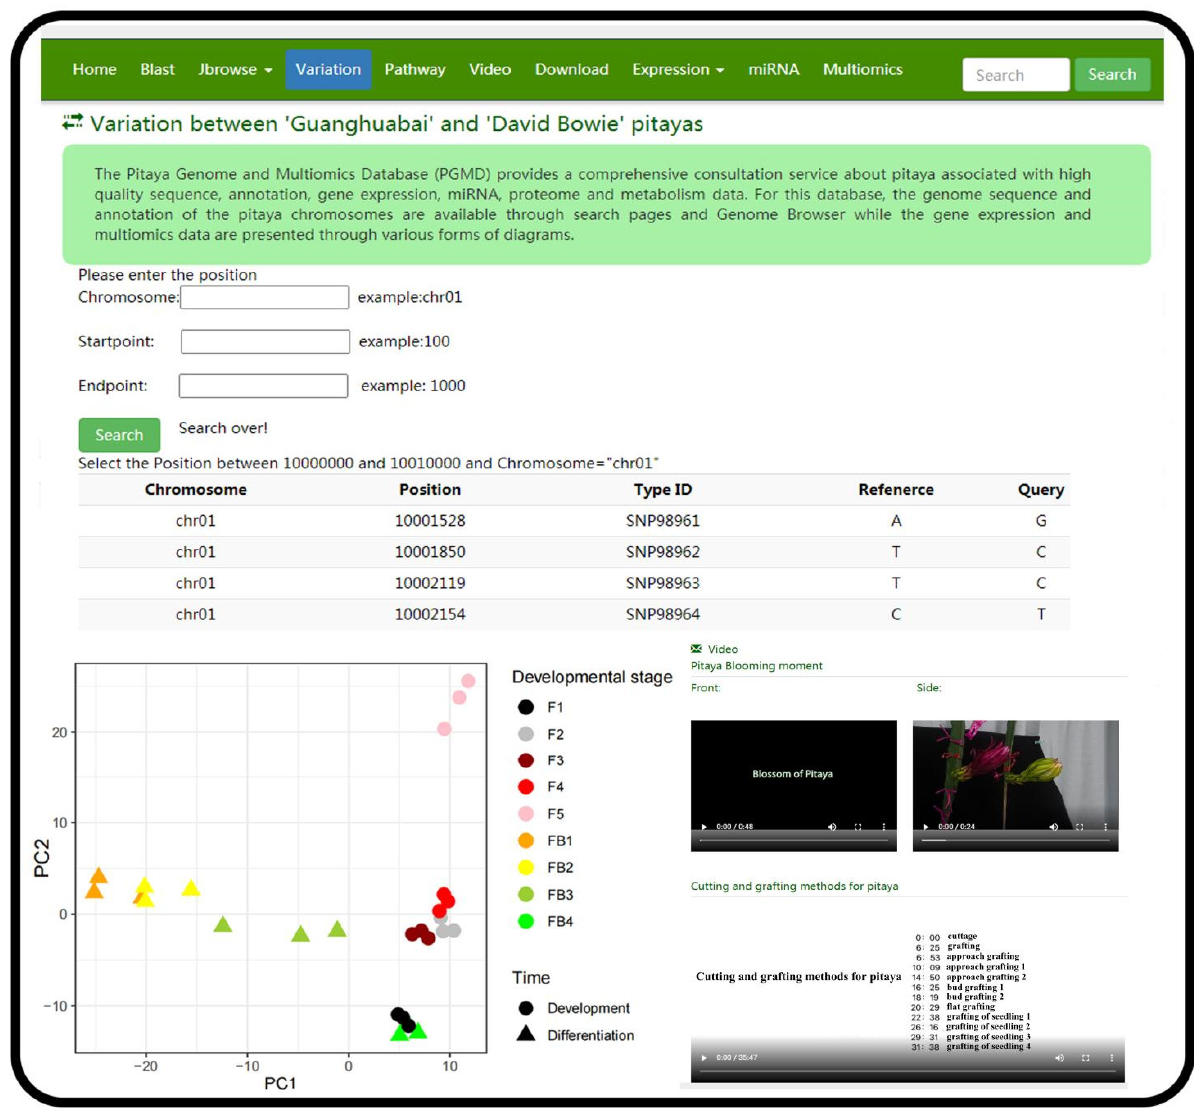
Figure 2. The screenshots of representative resources and action page examples for the ‘Variation’ and ‘Video’ modules. The ‘Variation’ and ‘Video’ module demonstrated genomic diversity among six pitaya cultivars, pitaya-related scientific periodicals and tutorial video; the PCA scatter diagram indicates the reproducibility and representativeness of the gene expression data.